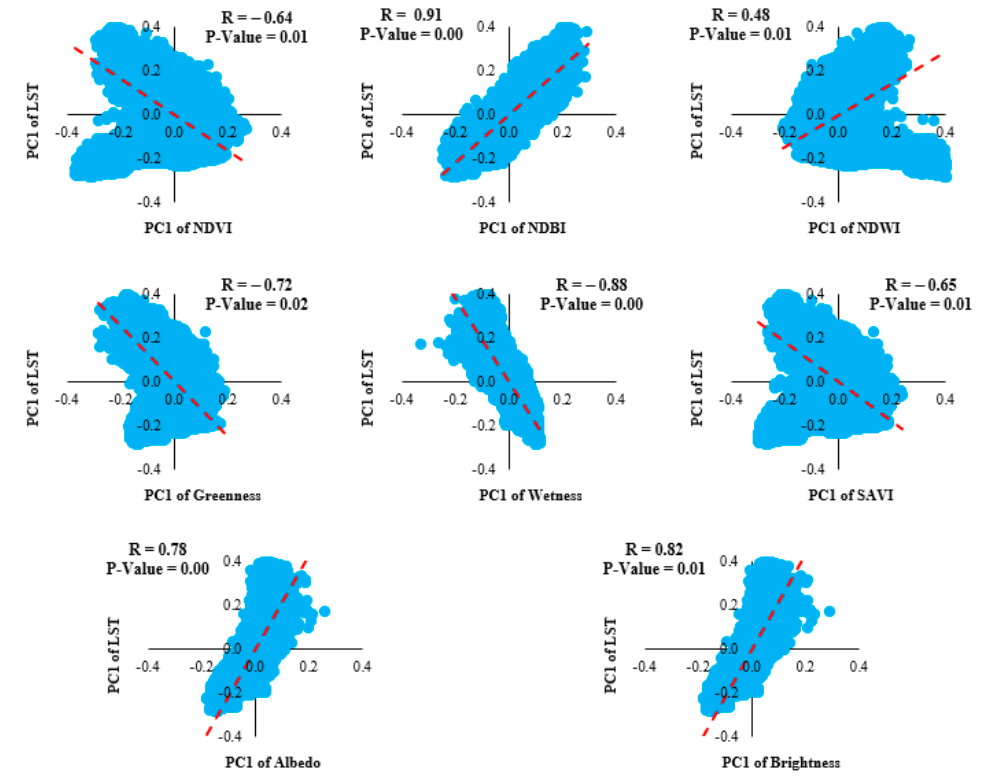
Table 3. Mean and standard deviation of the correlation coefficient and RMSE between the observed and modeled values of the LST variations at the pixel scale based on the variations of each surface biophysical parameters.